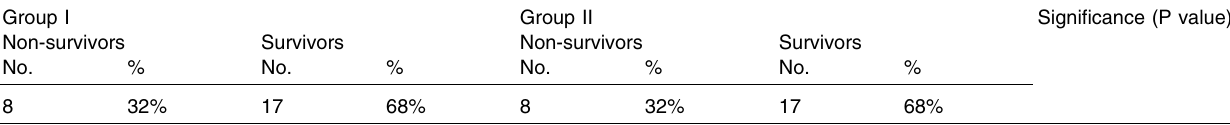
Table 16 Comparison between the two groups regarding mortality at day 28 using Pearson Chi-Square Test Group